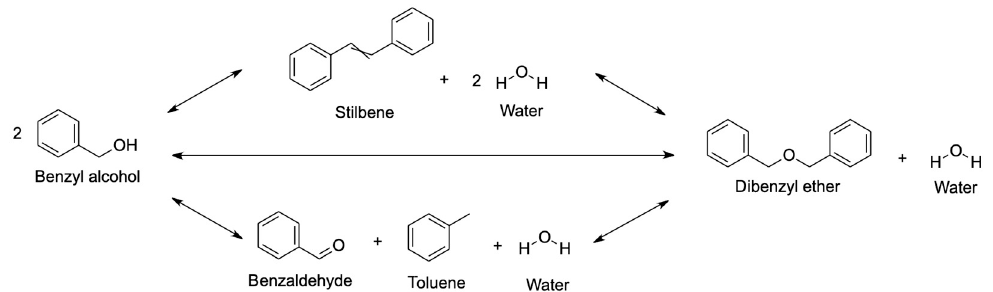
Figure 11. Reaction mechanism of glycerol etherification with benzyl alcohol [99].